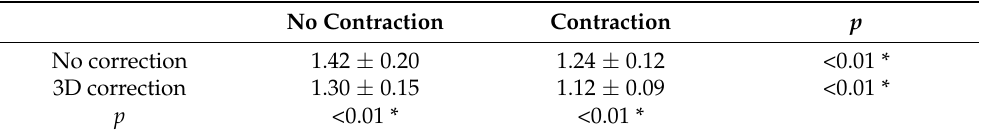
Table 4. Two-way ANOVA results of the interaction effects between 3D postural correction and abdominal muscle contraction ( n = 11). No Contraction Contraction p No correction